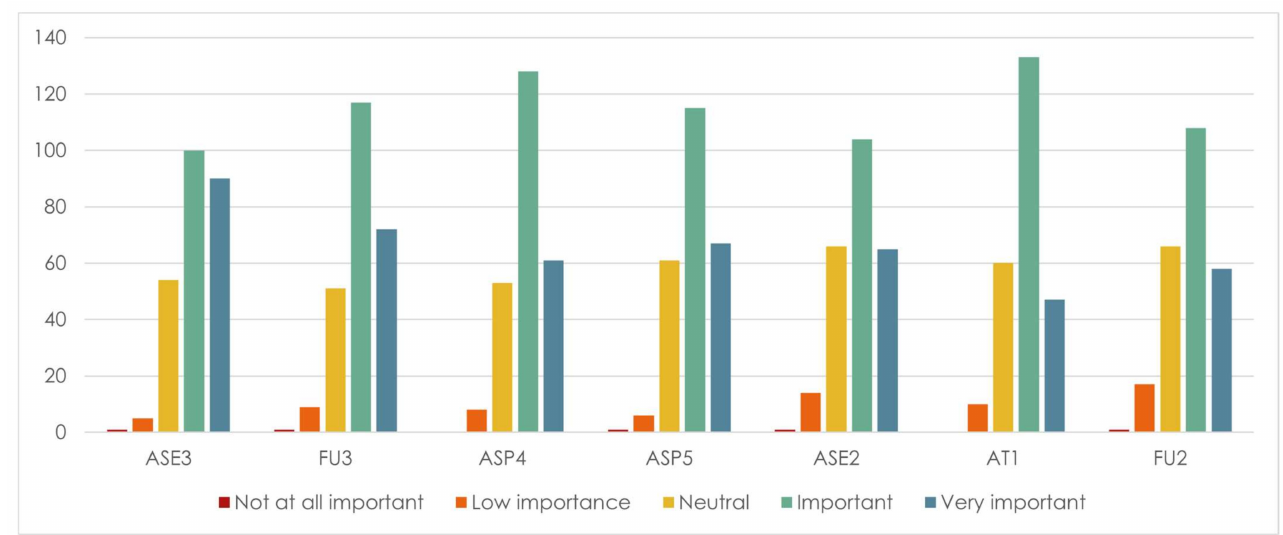
Figure 3. Perceived importance of increasing accessibility .